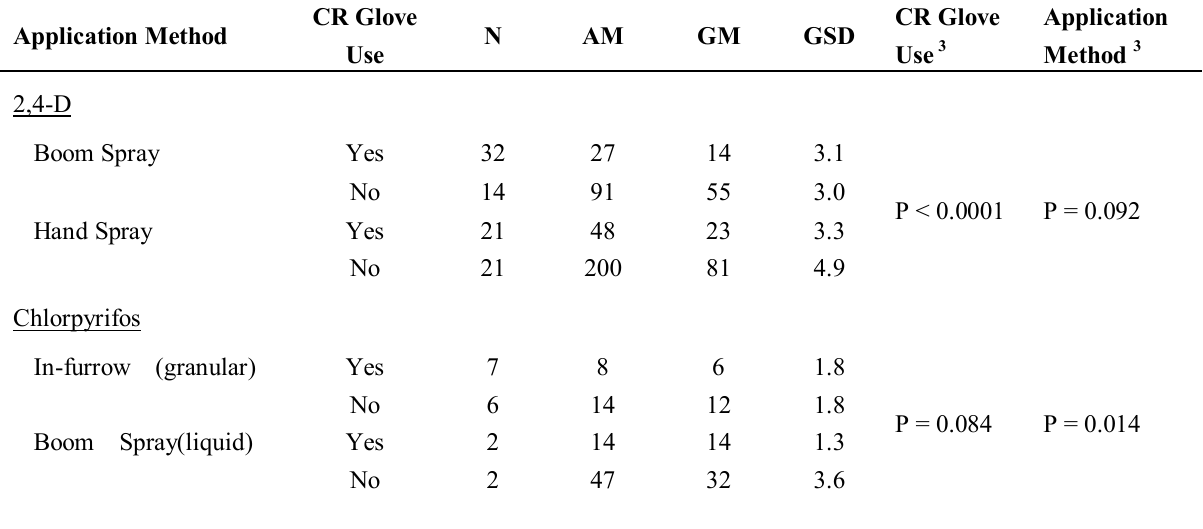
Table 1. Post-application urine concentrations (µg/L) grouped by application method and CR glove use for 2,4-D 1 (N = 88) and chlorpyrifos 2 (N = 17)